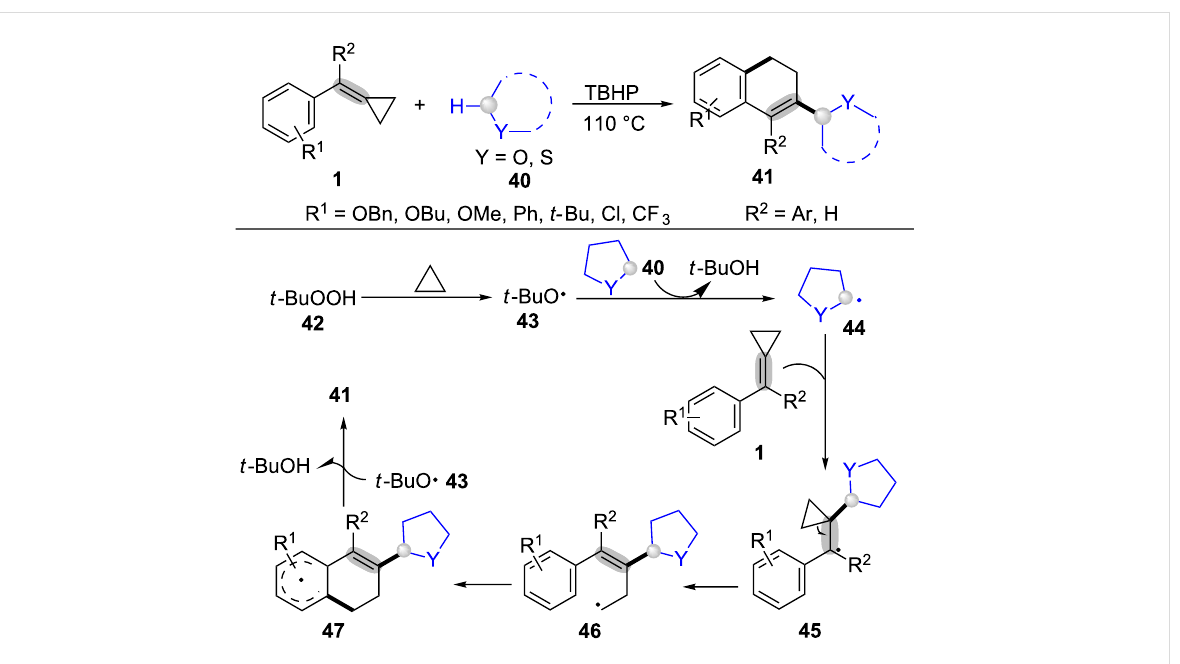
Scheme 11: oxidative radical ring-opening and cyclization of MCPs with α -C(sp 3 )-–H of ethers.